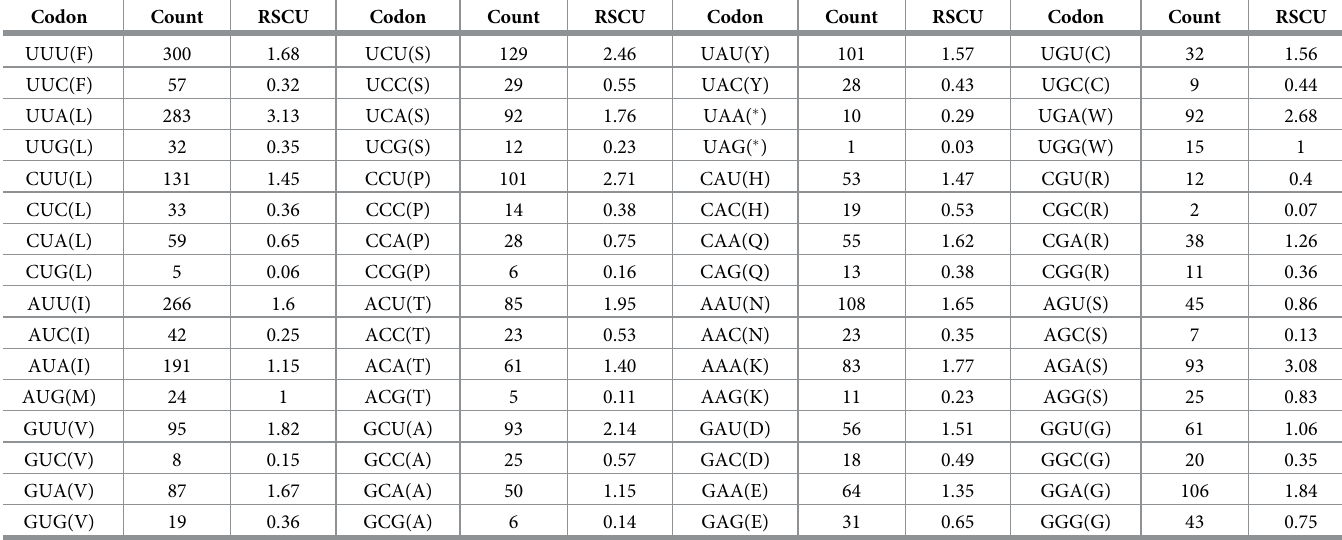
Table 3. The codon number and relative synonymous codon usage (RSCU) in L . vittata mitochondrial protein coding